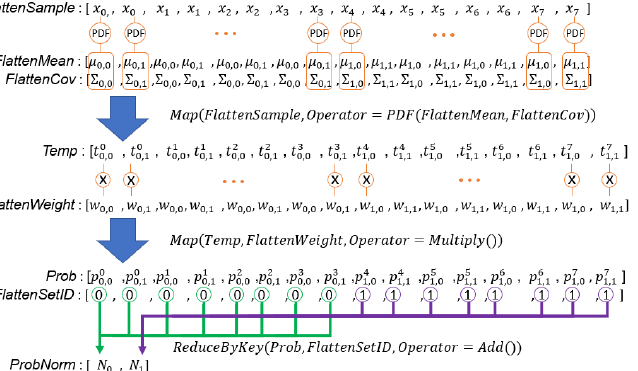
Figure 13. Illustration of E-step computation by data-parallel primitives. w i , j , µ i , j , and σ i , j are the weight, mean vector, and covariance matrix of the j th Gaussian component in the i th set. t k probability density computed from the k th sample and the j th Gaussian component in the i th set. N i is ProbNorm of the GMM of i th